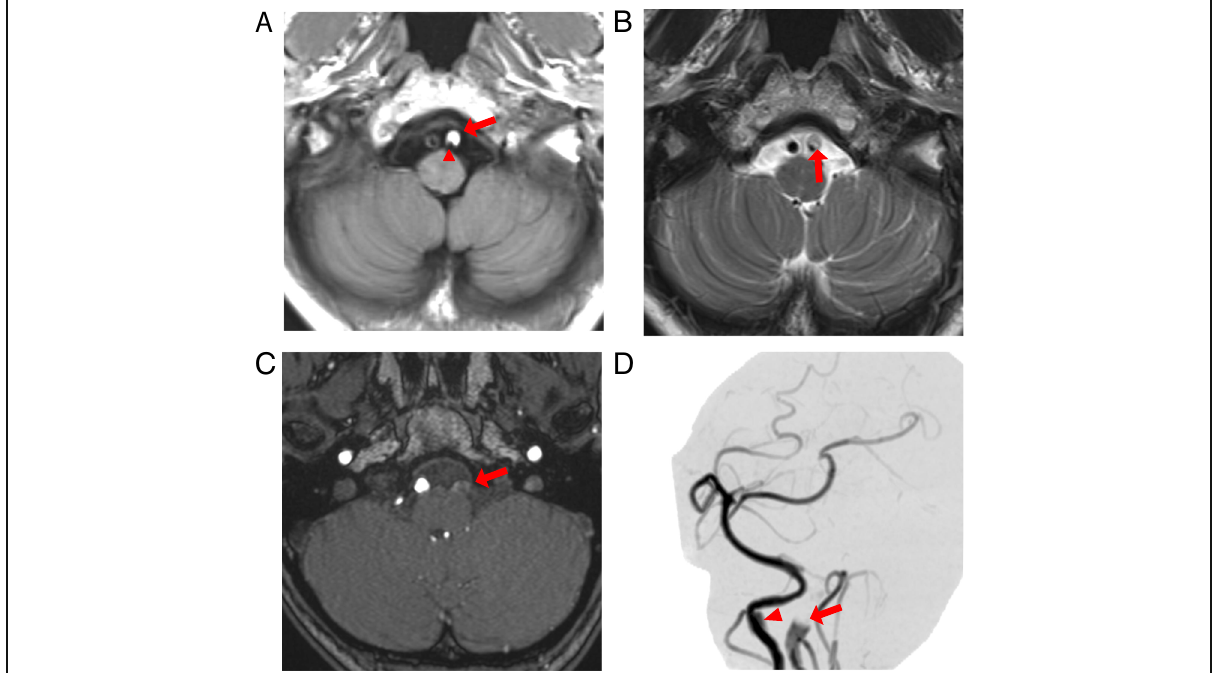
Fig. 1 3T magnetic resonance imaging of the head. a T1-weighted images showed a high-signal intensity lesion (arrow) and narrowing of the residual signal void (arrowhead) of the left vertebral artery. b T2-weighted images showed a curvilinear high-signal structure and an intimal flap (arrow), suggesting left vertebral artery dissection and intramural hematoma. c and d Three-dimensional time-of-flight magnetic resonance angiography showed obstruction of the left vertebral artery (arrow), an aneurysm related to dissection of the right vertebral artery